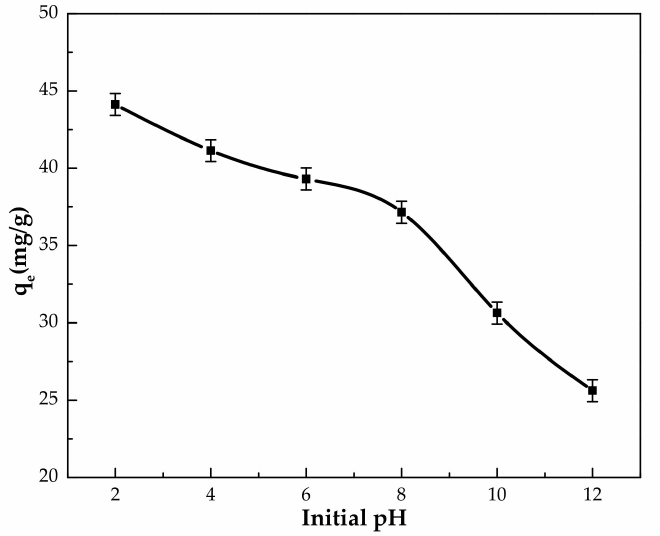
Figure 9. The effect of initial pH of phenol solution on the adsorption capacity by IL–agar–alginate